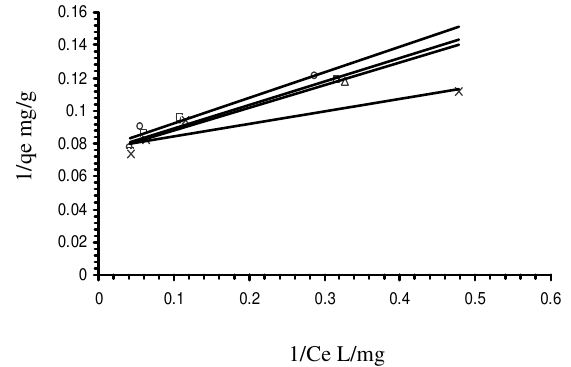
Figure 6. Langmuir plot for the adsorption of Cu(II) onto PFA, 2 g/L, at different temperature pH 6 contact time 2.